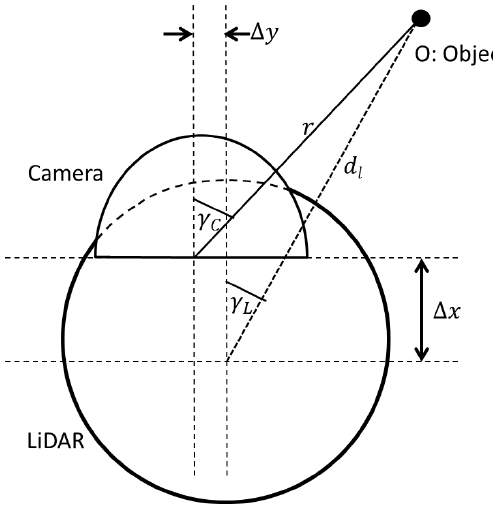
Figure 2. Side view of the sensor setup.